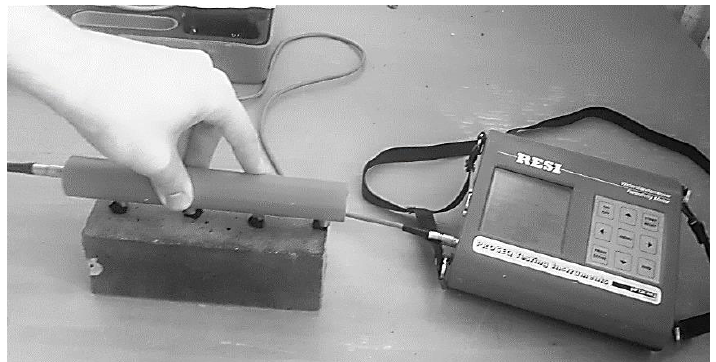
Figure 2. Example of measuring the surface resistivity of a prismatic sample.